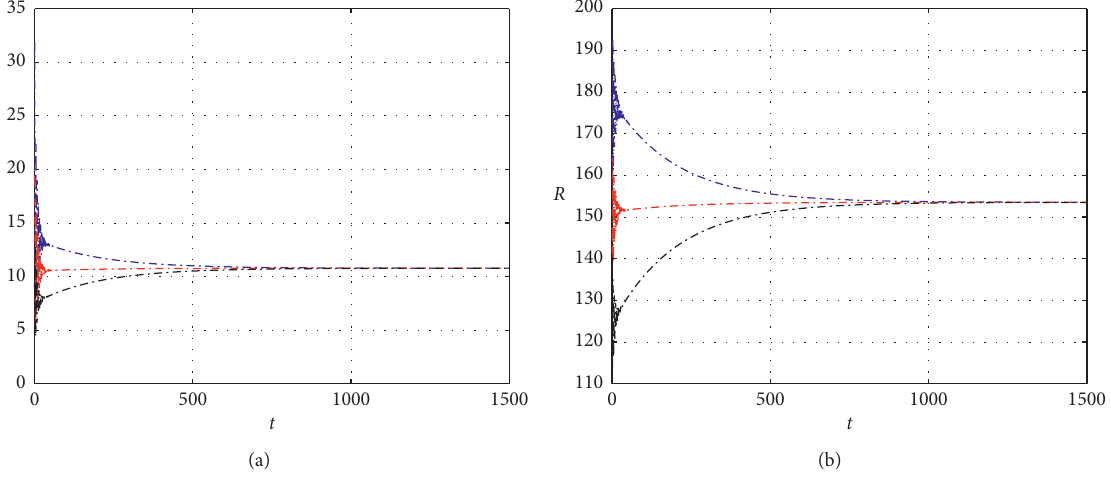
of system (4) when q 2 ∗